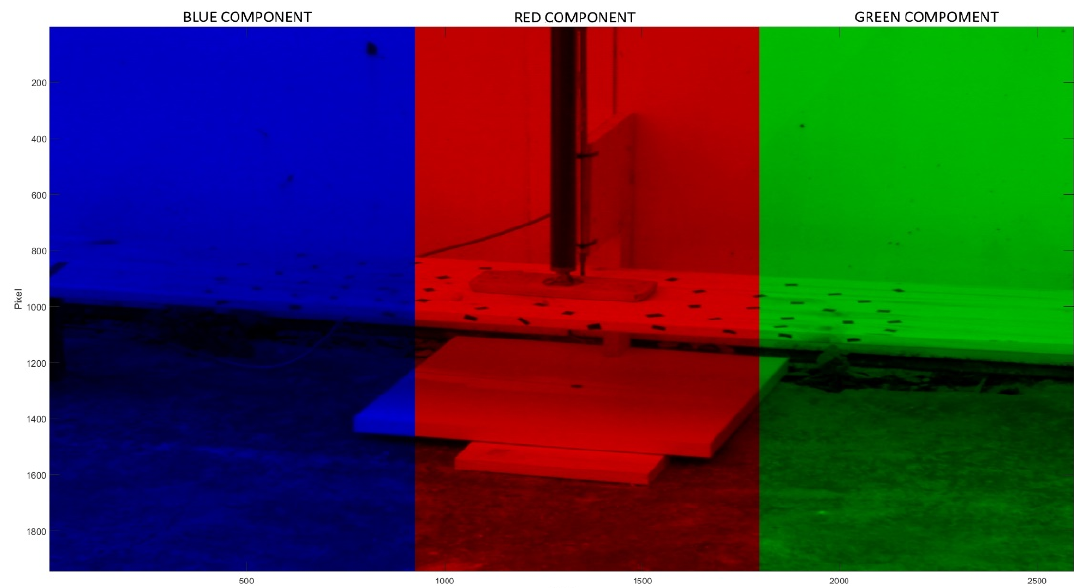
Figure 9. Composition of RGB channels of an RGB+D image (Source: Own compilation).